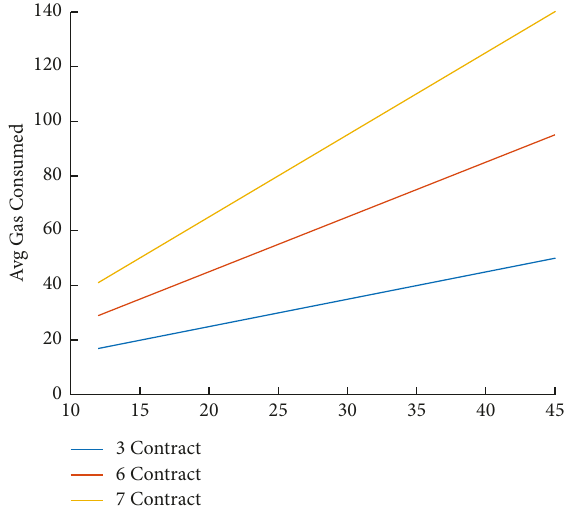
Figure 11: The average gas consumption.